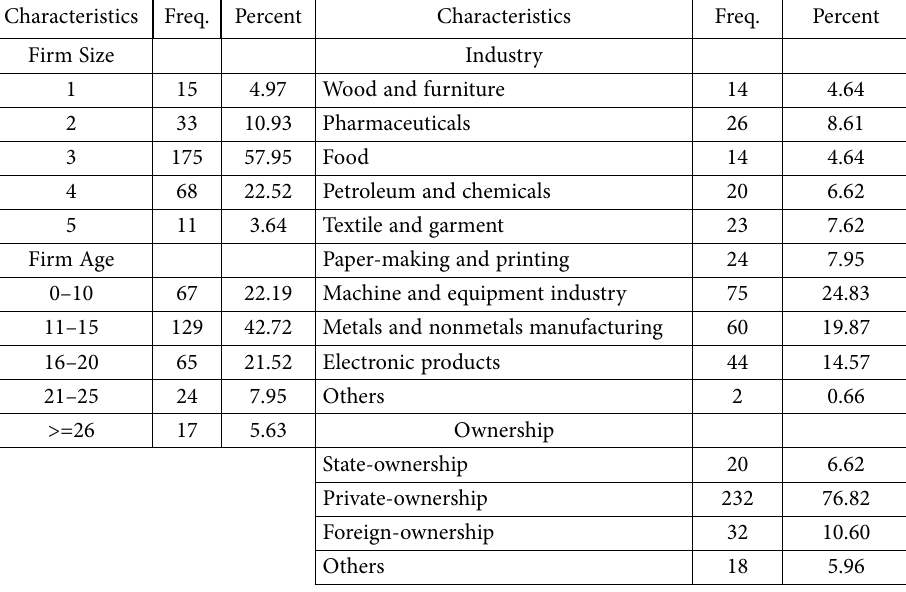
Table 1. Statistical characteristics of the